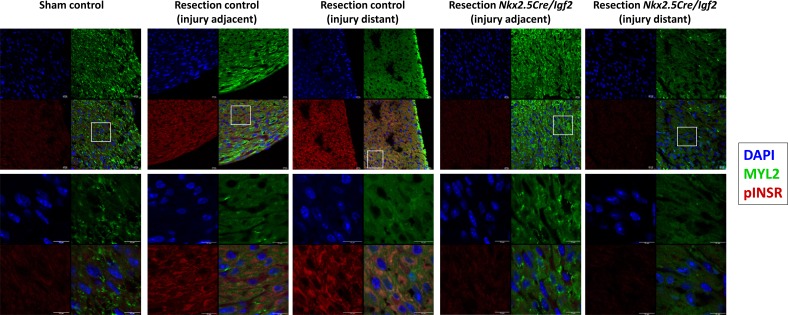
Confocal imaging of phospho-INSR staining at 3dpr.Low magnification images showing each individual channel (DAPI, Myl2, pINSR) and the merged image are grouped above, the boxed region in each is shown at higher magnification below. Scale bars in all panels are 10µ. The injured myocardium in the injury adjacent images are slightly beyond the frame of these images. As in Figure 4, note positive pINSR staining in resected control but not in uninjured (sham) control or in resected Nkx2.5-Cre/Igf2 mutant hearts.